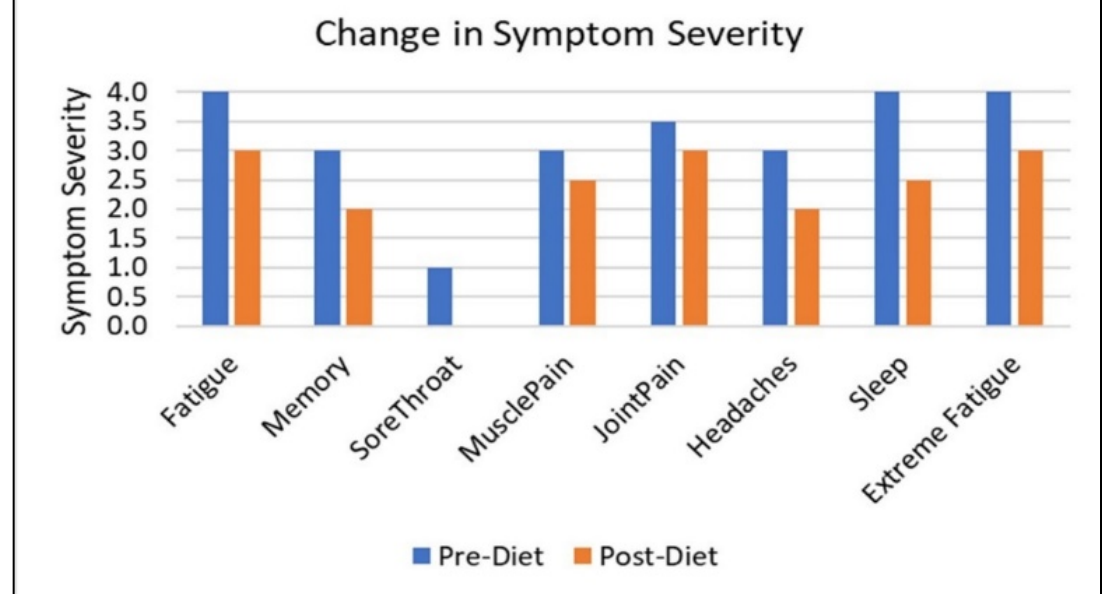
Figure 4. Median symptom severity pre–post diet.